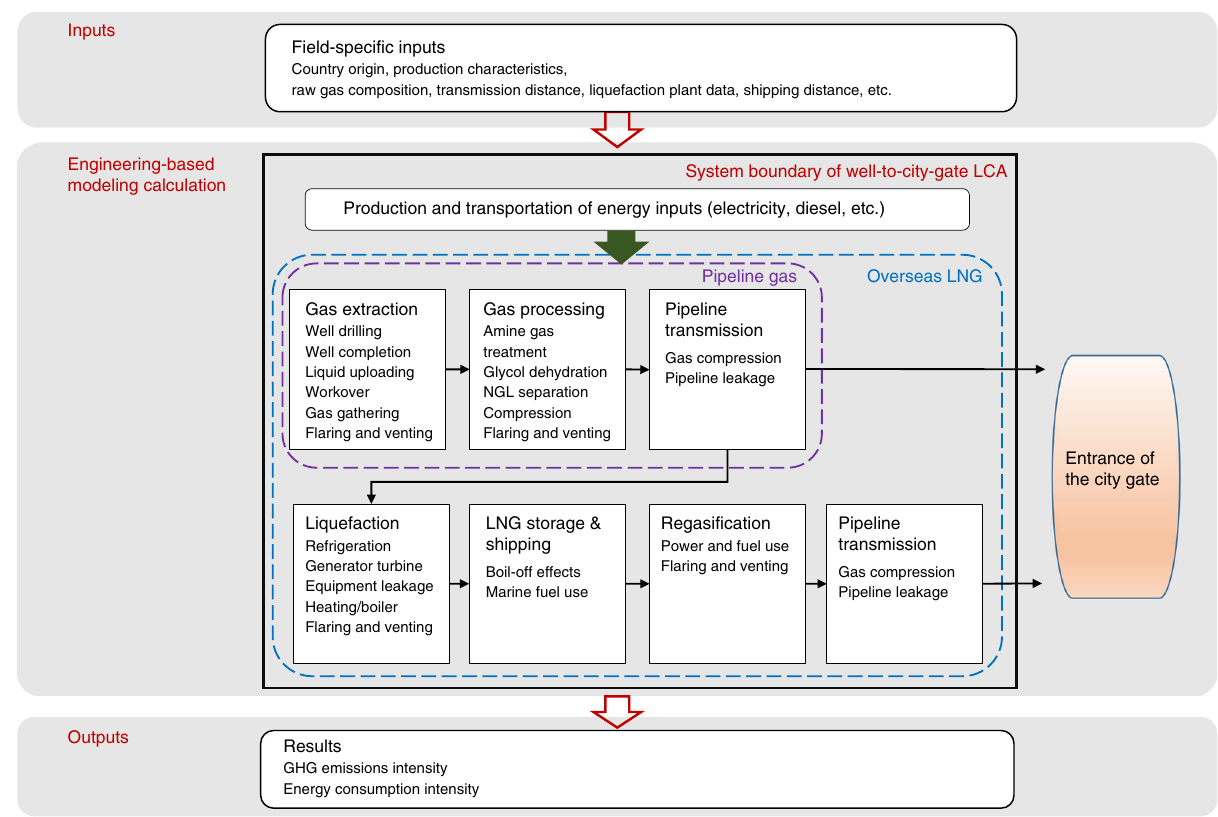
Fig. 6 System boundary and structure of the natural gas well-to-city-gate LCA model. Field-speci fi c inputs are fed into the engineering-based LCA model to calculate GHG emissions intensities of gas supply from different gas fi elds. System boundary of the LCA study is shown in the bold black box in the middle of the fi